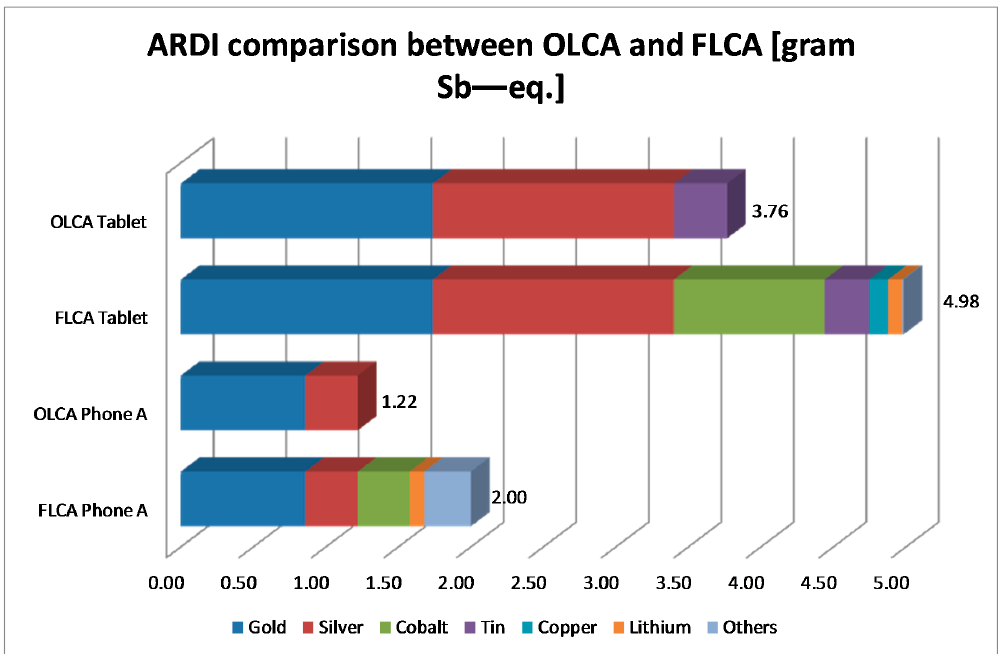
Figure 11. Repartition for ARDI for Phone A and tablet comparing FLCA and OLCA.